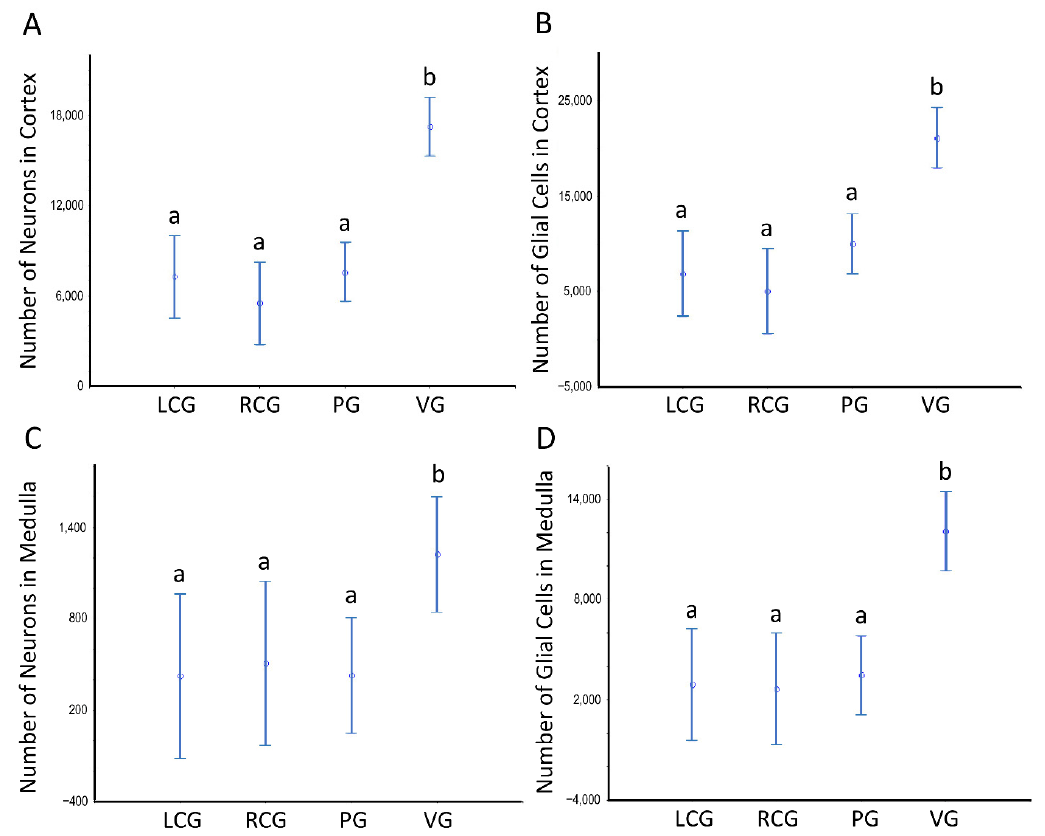
Figure 9. Number of neurons and glial cells in the cortex and medulla of ganglia of S. plana ; data from all sex conditions combined. ( A ) Neurons in the cortex. ( B ) Glial cells in the cortex. ( C ) Neurons in the medulla. ( D ) Glial cells in the medulla. Different letters mean significant differences. Data as mean and 95% confidence interval ( p < 0.05). LCG: left cerebral ganglion; RCG: right cerebral ganglion; PG: pedal ganglion; VG: visceral ganglion. Six animals per sex condition were used.